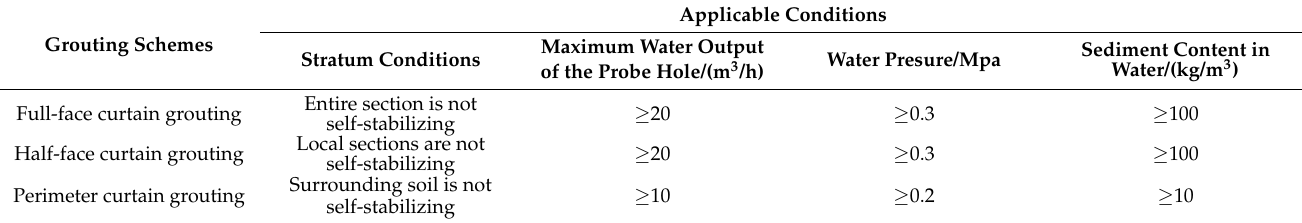
Table 8. Curtain grouting